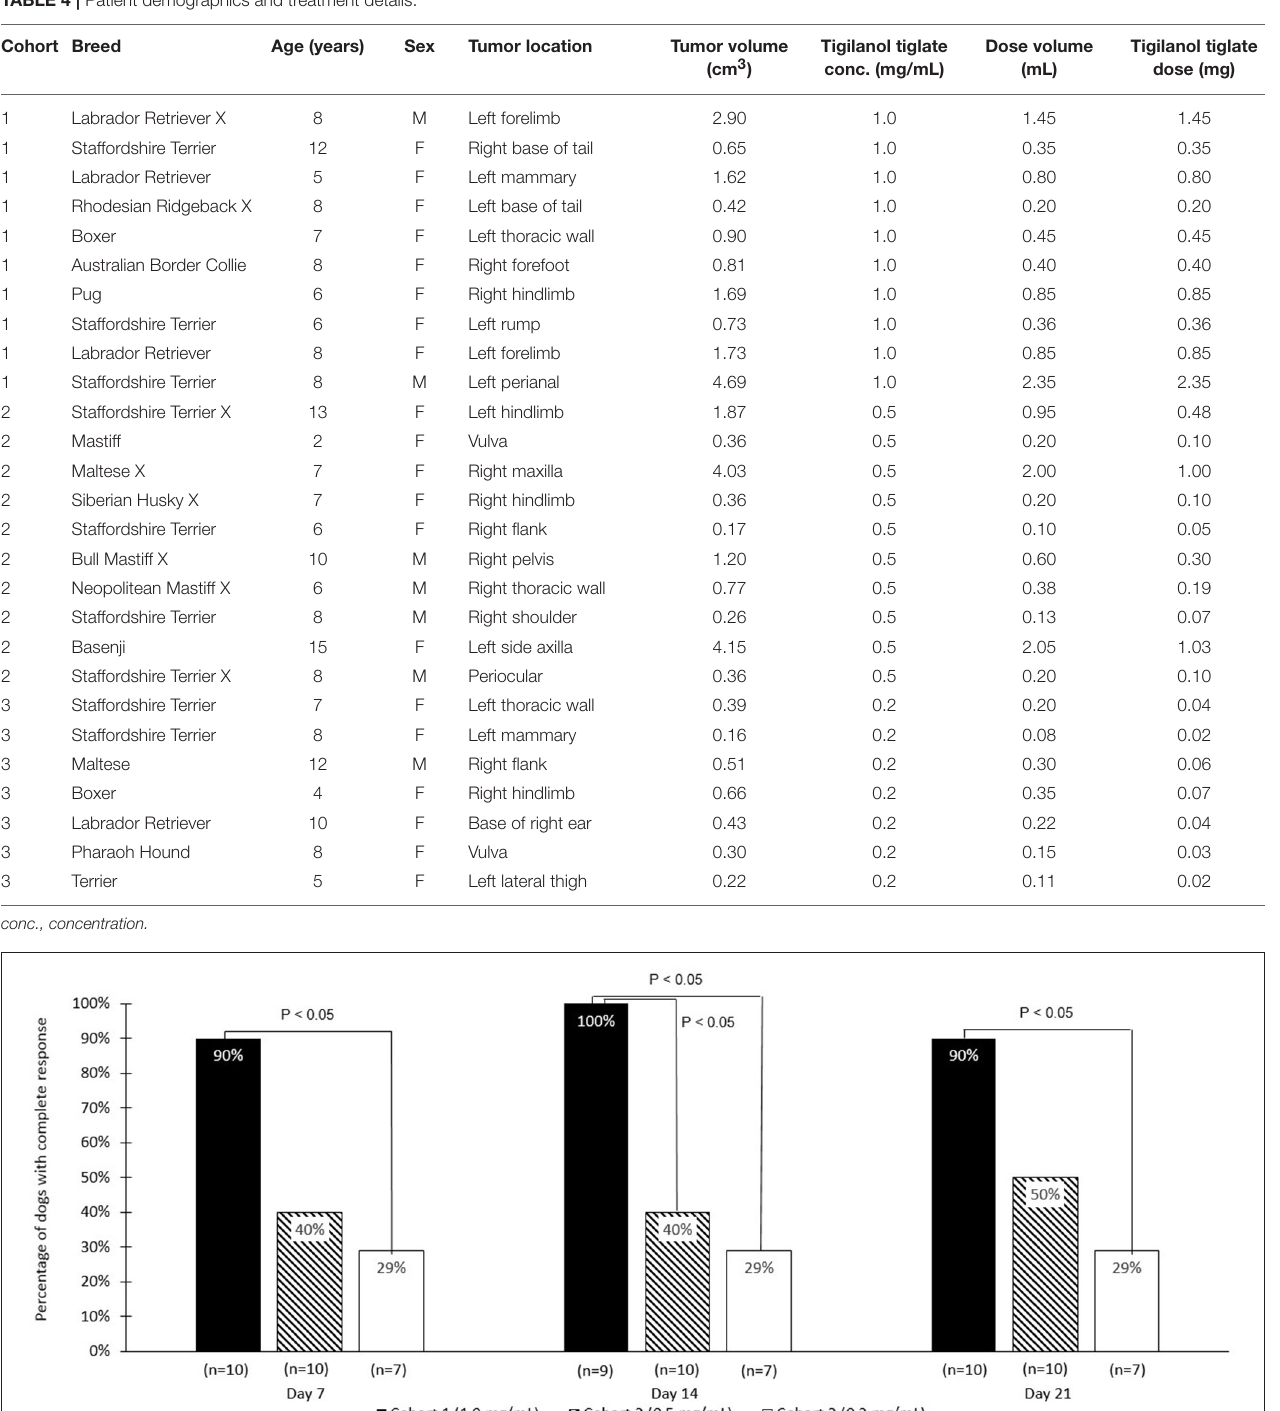
TABLE 4 | Patient demographics and treatment details.